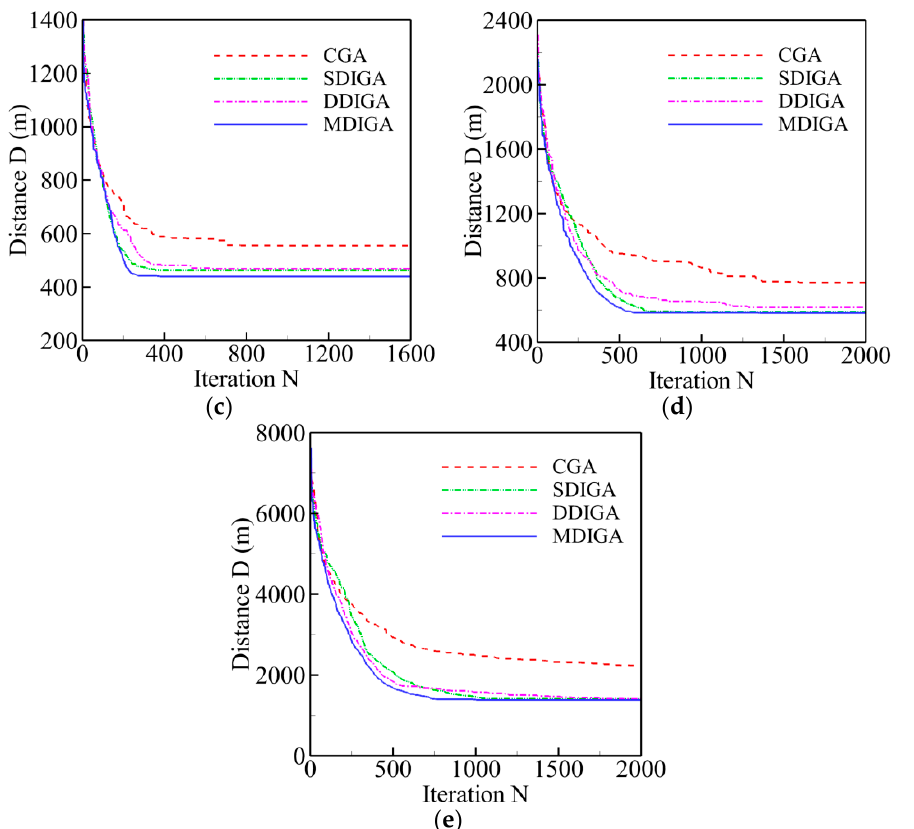
Figure 9. Convergence history of optimal path distance versus iterations for each algorithm: ( a ) P = 14; ( b ) P = 22; ( c ) P = 51; ( d ) P = 76; ( e ) P = 99. Table 6. Simulating results of computing e ffi ciency for each